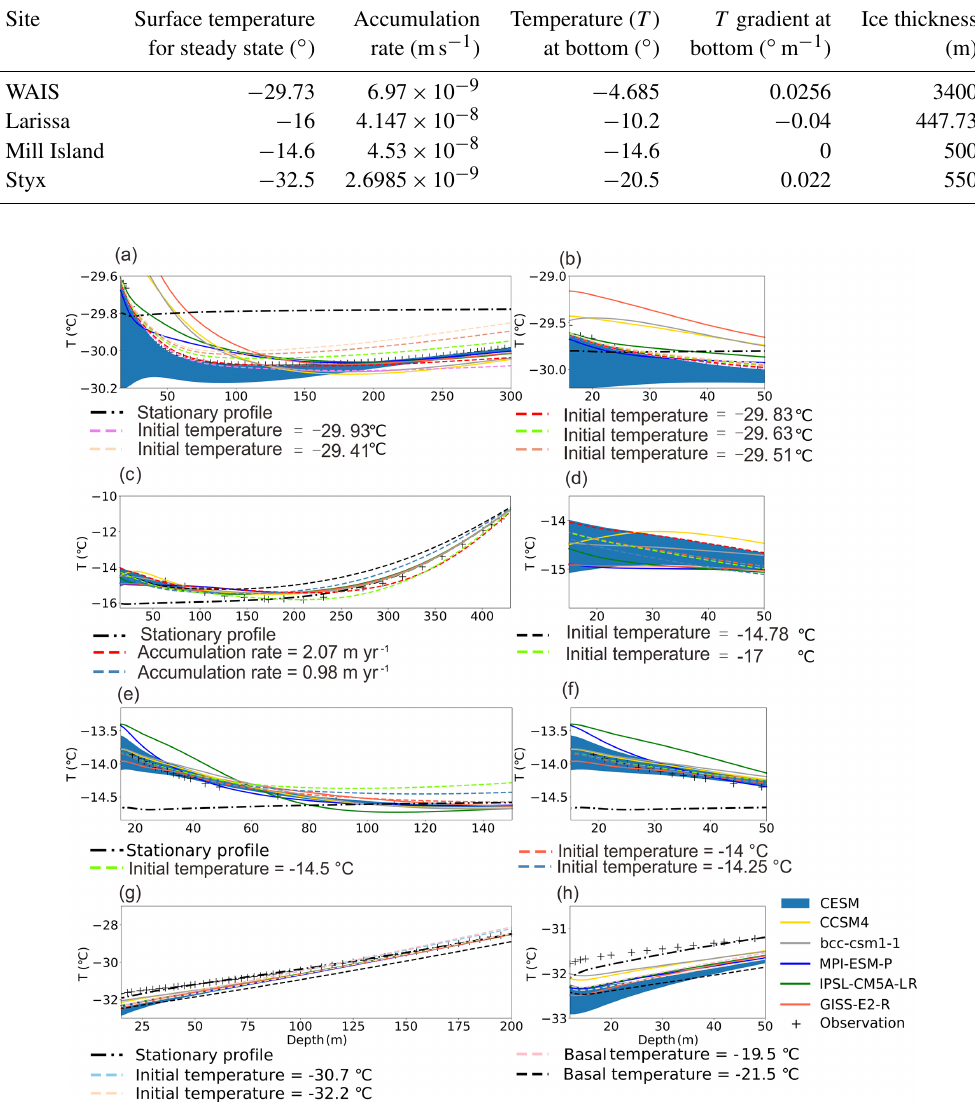
Figure 2. Comparison of borehole temperature profiles outputs for the forward model driven by GCM surface-temperature time series with optimal parameters (solid lines), and sensitivity tests using the temperature history of one CESM member (dashed lines) at each site. (a) WAIS: 15–300m; (b) WAIS: 15–50m; (c) Larissa: 15–430m; (d) Larissa: 15–50m; (e) Mill Island: 15–150m; (f) Mill Island: 15–50m; (g) Styx: 15–200m; (h) Styx: 15–50m. The shaded area represents the simulated subsurface temperature ensemble driven by CESM using optimal parameters. The thick dash–dot line denotes the stationary profile at each